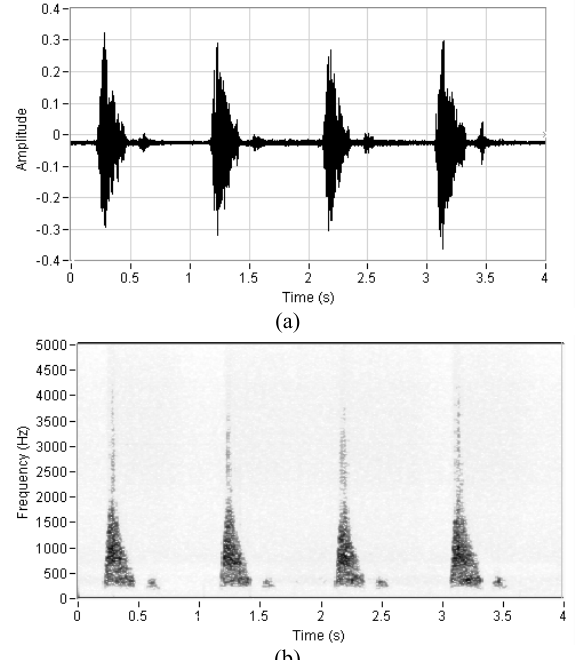
Fig. 9. An example of blood flow (a) and its spectrogram (b) for the brachial artery in a normal condition.